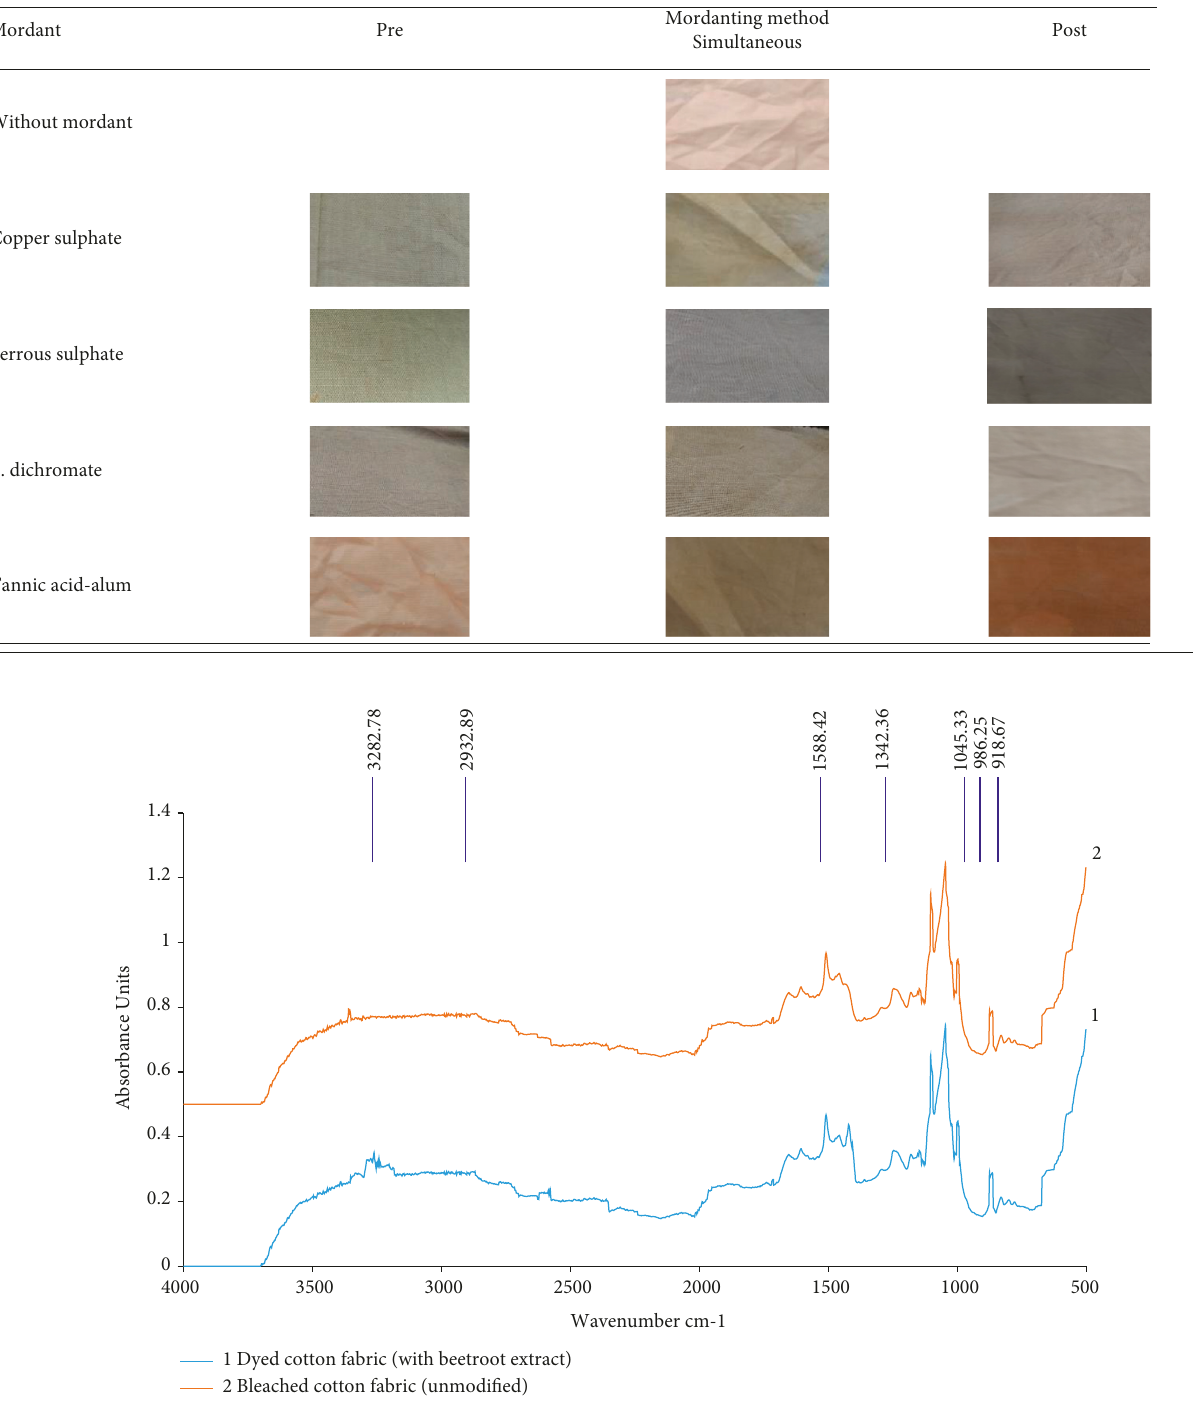
Table 4: Effect of mordants on shades of B. vulgaris dye extract.